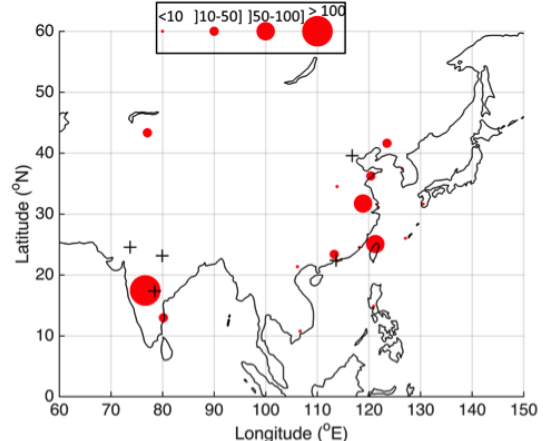
Figure 3. In red and scaled to number of observations: location of the MOZAIC/IAGOS flight data at the different airports in our study domain and period. The “ + ” sign locations corresponds to the ground stations used in Sect. 4 for the year 2011.